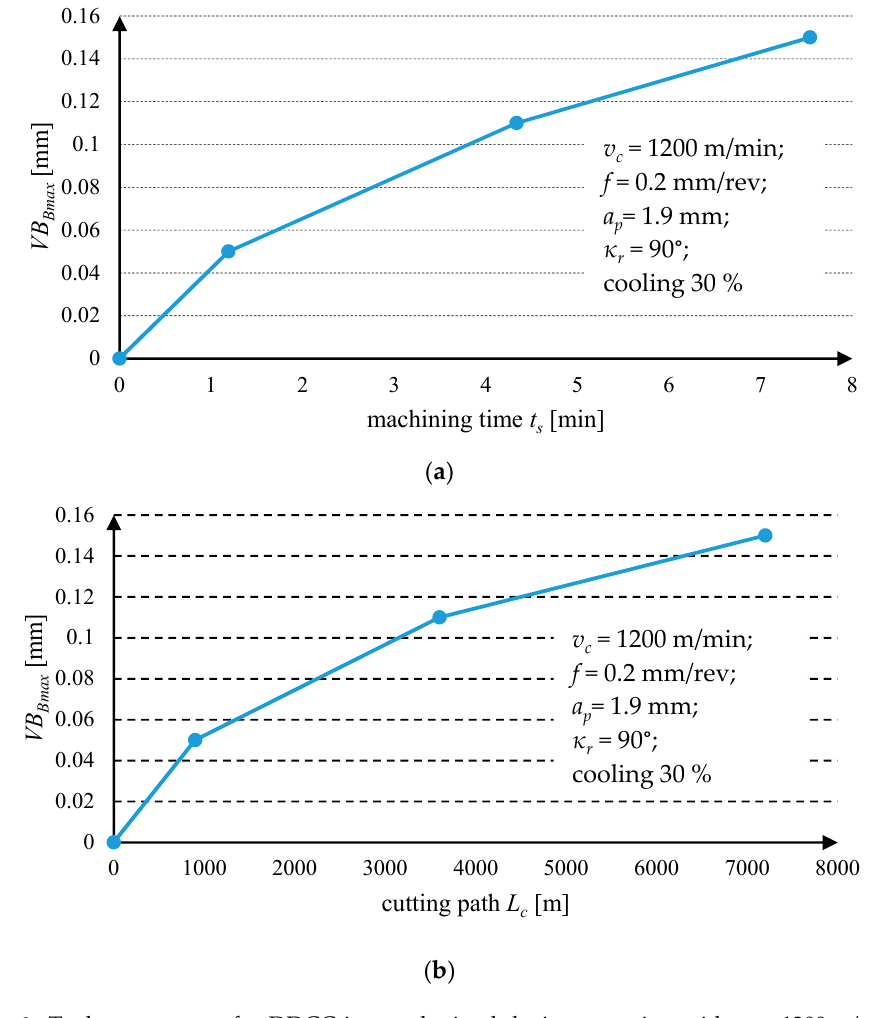
Figure 6. Tool wear curves for DDCC insert obtained during grooving with v c = 1200 m/min and f = 0.2 mm/rev in function of ( a ) cutting time; ( b ) cutting path.